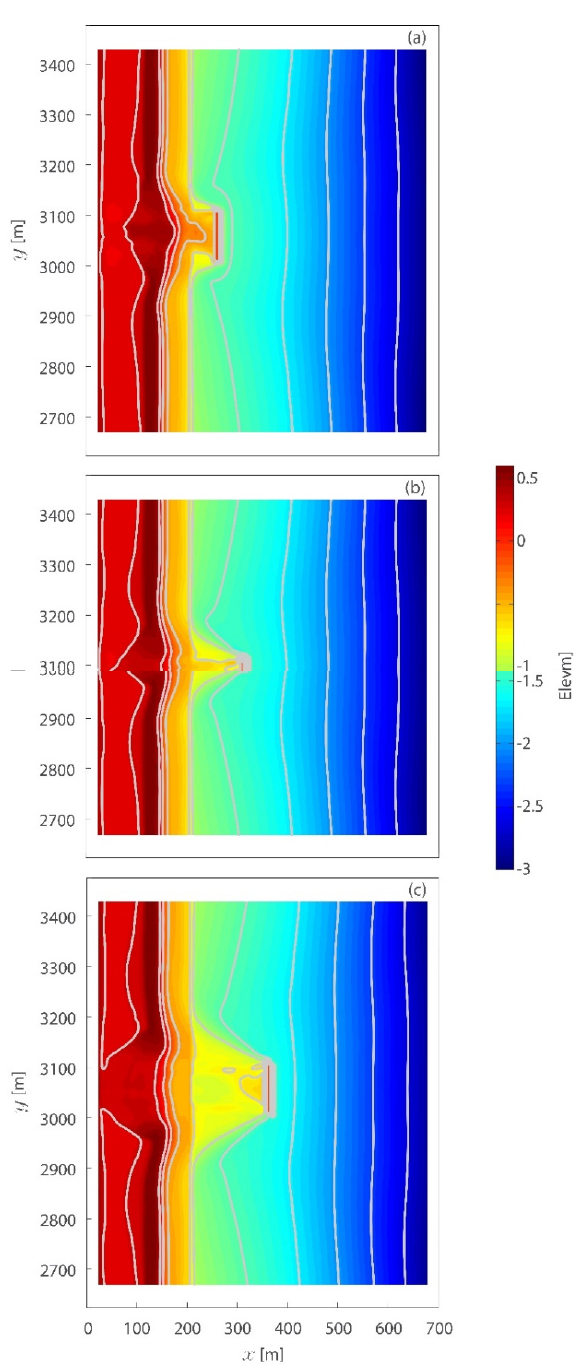
Figure 12. Long term simulation for ( a ) x d = 50 m, ( b ) x d = 100 m and ( c ) x d = 150 m. The Figure shows how these morphodynamic structures tend to be less accentuated with an increase in breakwater distance to the shoreline.